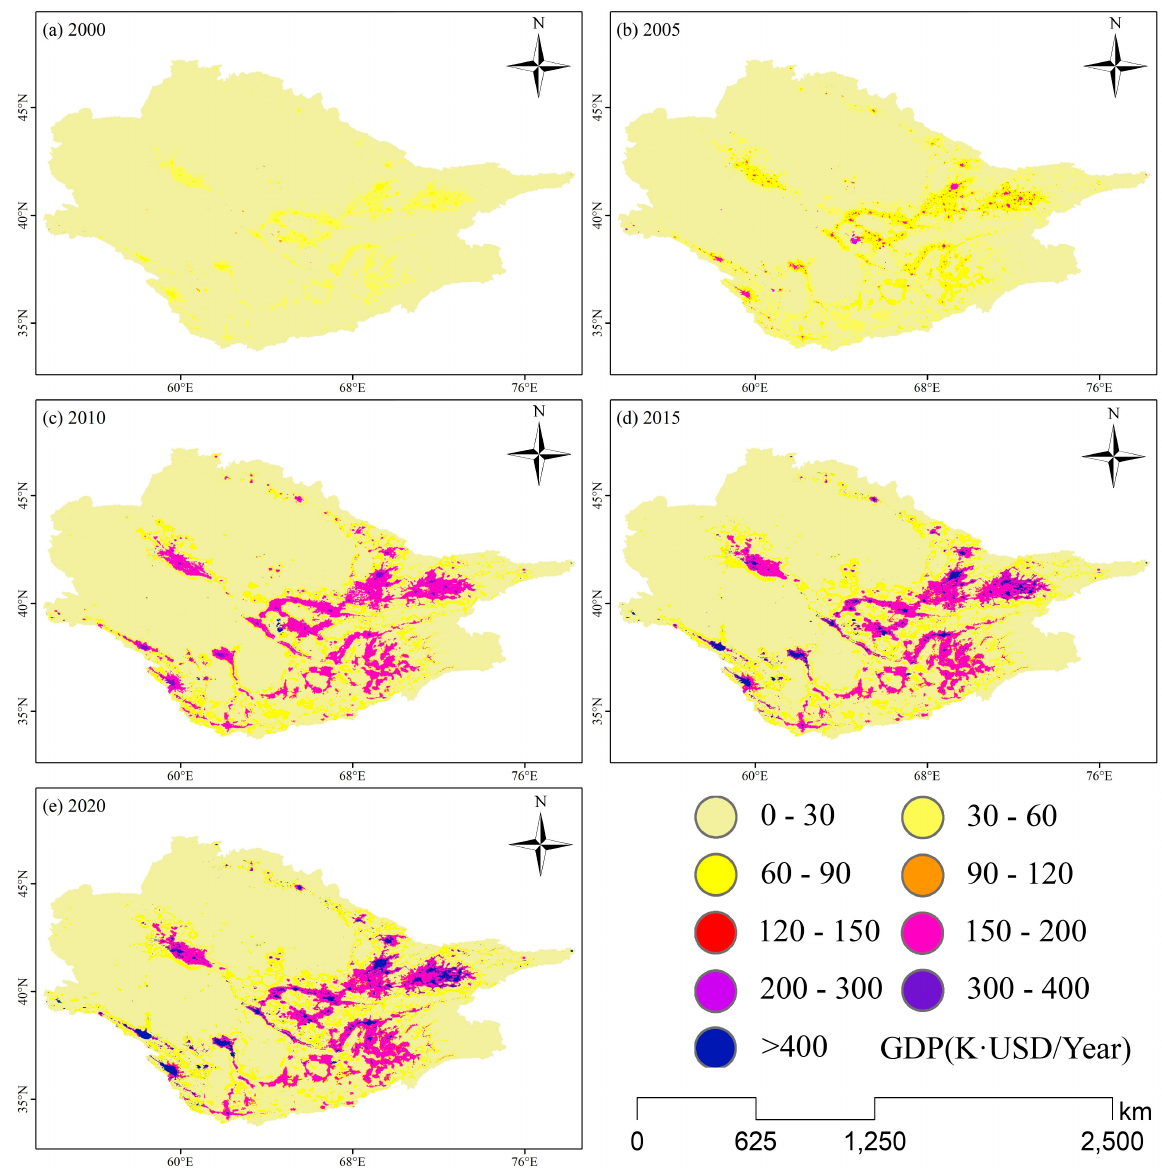
Figure 5. The spatial distribution of GDP in the ASB from 2000 to 2020 ( a – e ). At the same time, the areas with higher GDP are consistent with the distribution range of cultivated land and water bodies, so we draw on the research results of Chen et al. [53] to calculate the total water area and GDP of the ASB from 2000 to 2020 and further analyze the relationship between them (Figure 6). The results showed a strong negative correlation between GDP and water area, with R 2 being 0.8, and Pearson’s being